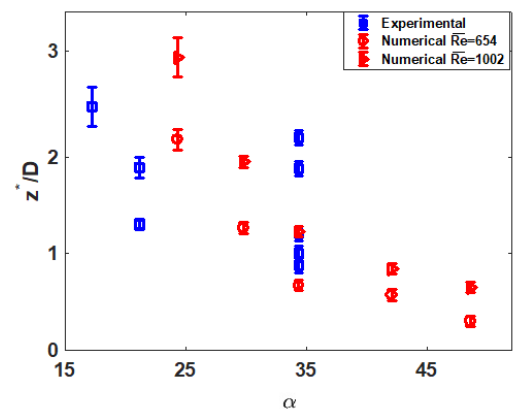
Figure 10: Dependence of the dimensionless maximum vortex displacement on α . Experimental results in blue squares and numerical results in red circles ( ¯ Re = 654) and red triangles ( ¯ Re = 1106).